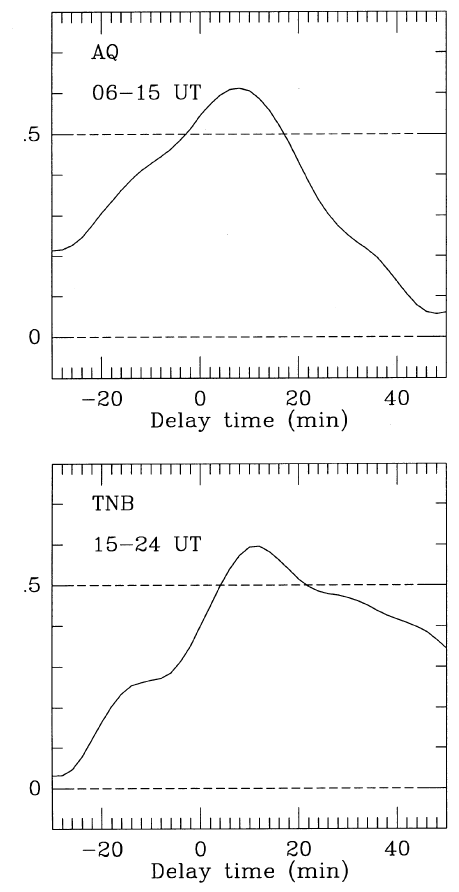
Fig. 2. Normalized cross-correlation function between cos( h the logarithm of the Pc3 power at AQ ( upper panel ) and TNB ( lower panel )